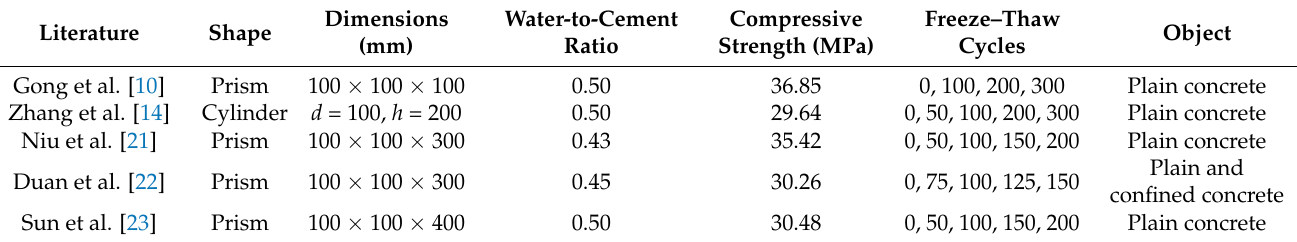
Table 1. The design parameters of the